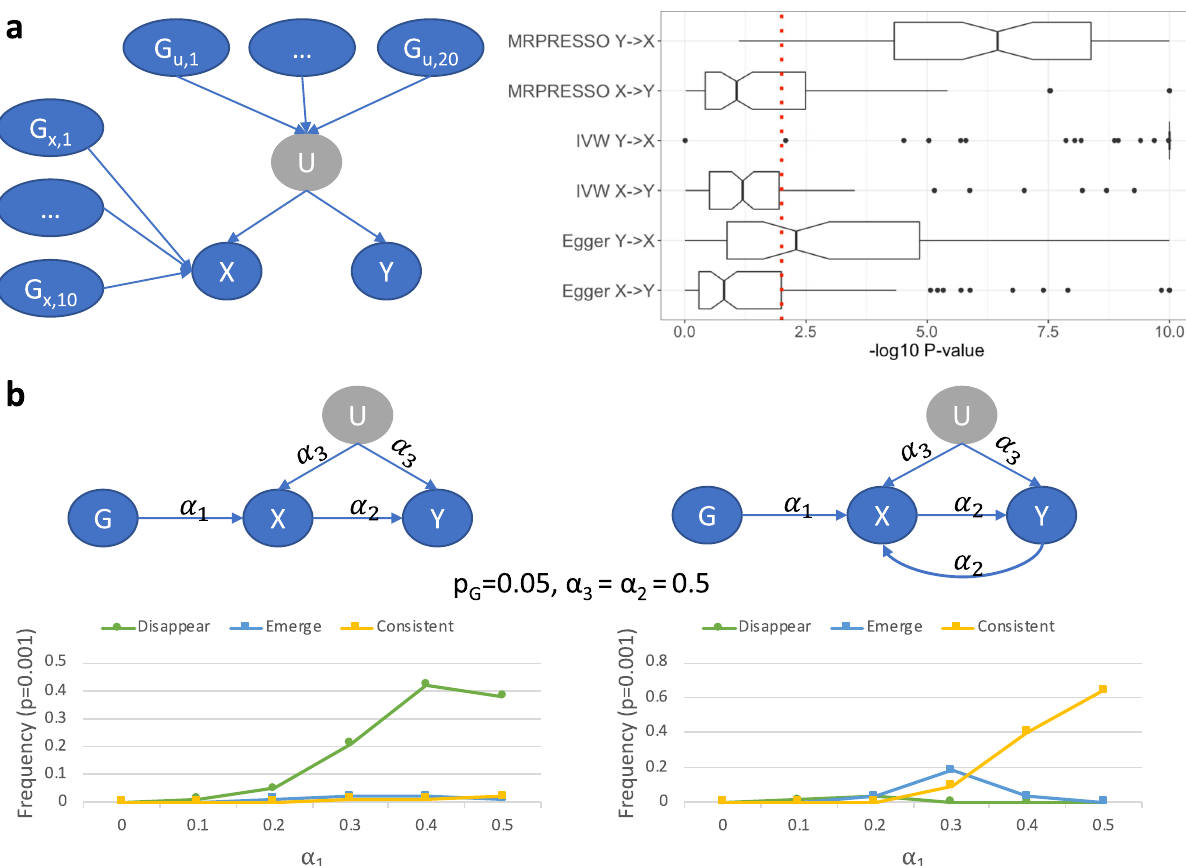
Fig. 2 Simulations of simple graphs illustrate some limitations of MR and the faithfulness assumption. a When simulating from linear models from the presented graph ( n = 2000 samples), MR methods tend to erroneously predict causal links between X and Y . The left panel shows the graph, where the gray node U is an unobserved common cause (confounder) of X and Y . The right panel shows the distribution of the ( − log10) p -values of different MR methods when analyzing X and Y . Each boxplot shows the median, and fi rst and third quartiles. The whiskers extend from the hinge to the largest and lowest values, but no further than 1.5 * (the inter-quantile range). As input for MR, summary statistics were computed using linear regression and instruments were selected using a p < 10 − 04 cutoff. b Simulations from simple MR models with a single binary instrument show violations of faithfulness in fi nite samples. Each line presents the frequency of different dependency patterns between the simulated genetic instrument G and the phenotypes Y and X . In all simulated cases G and X were signi fi cantly associated at p < 0.001, and are thus not shown. Disappearing associations: G and Y are associated marginally, but become independent when conditioned on X ( p > 0.1). Emerging associations: G and Y are independent but become associated when conditioned on X . Consistent: G and Y are signi fi cantly associated with and without conditioning on X . Even though under faithfulness G and Y should be associated with and without conditioning on X (in both graphs, X acts as a collider on the path from G to Y through U ), we see mixed results. Nevertheless, the detected associations occur only when a non-blocked path exists between G and Y , satisfying our re fi ned local faithfulness